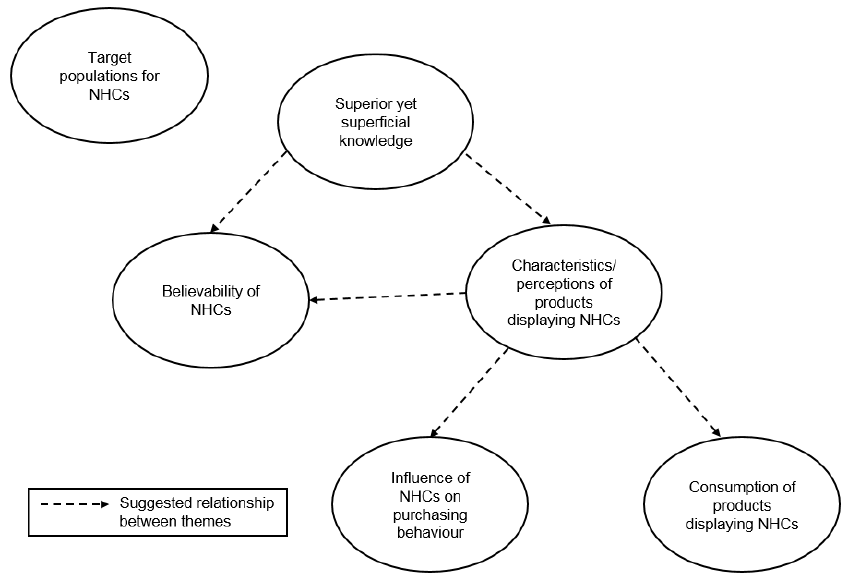
Figure 1. Relationships between constructed themes.